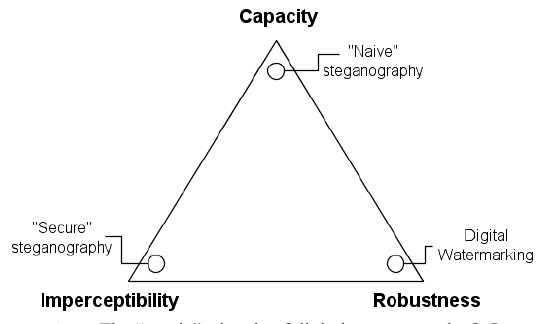
Fig. 4. The “magic” triangle of digital steganography